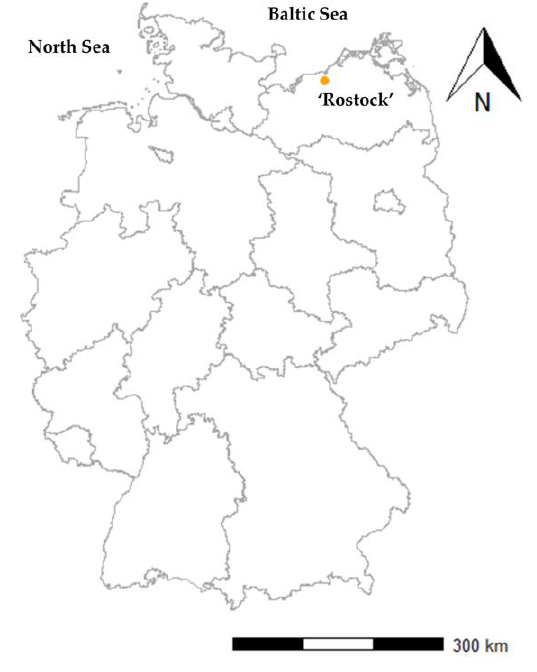
Figure 1. Study area of Rostock, northeast Germany.